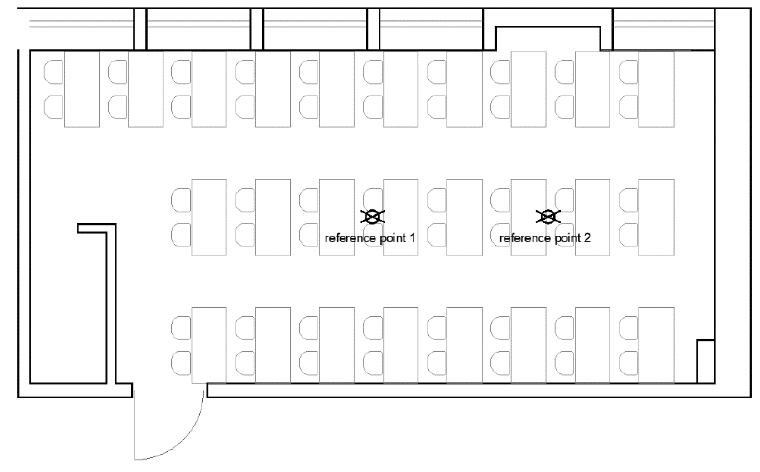
Figure 5. Location of reference points in the room.